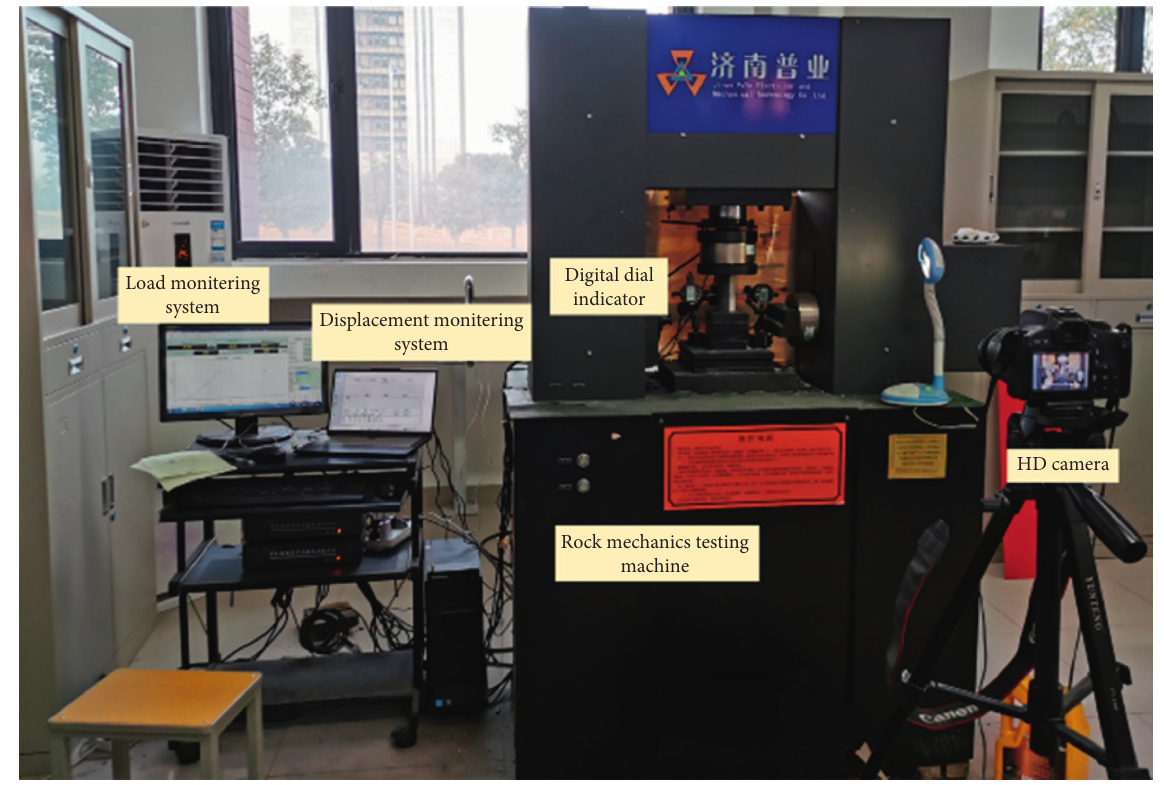
Figure 4: Rock mechanics testing machine.